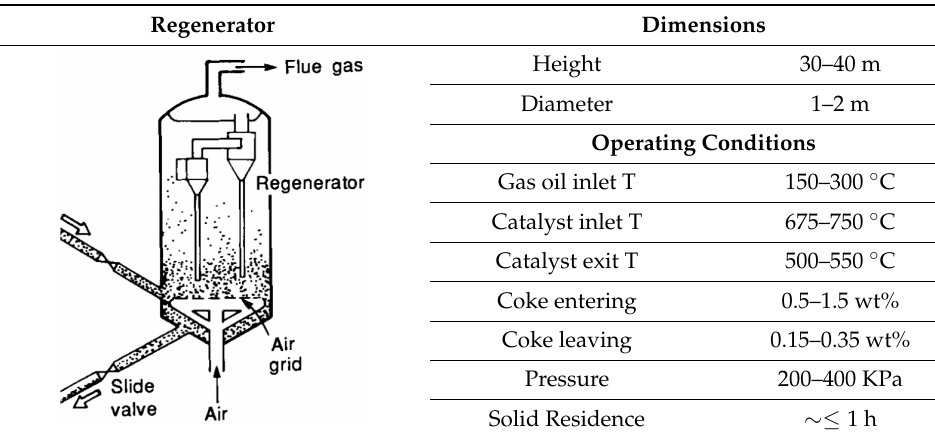
Table 1. Dimensions and Operating conditions of FCC unit